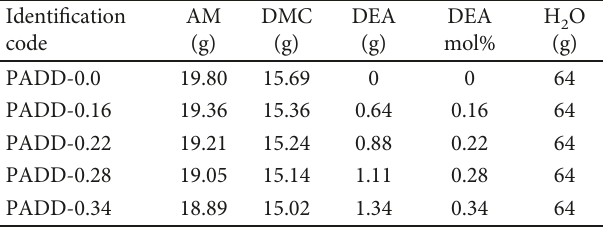
Table 2: Reaction conditions of